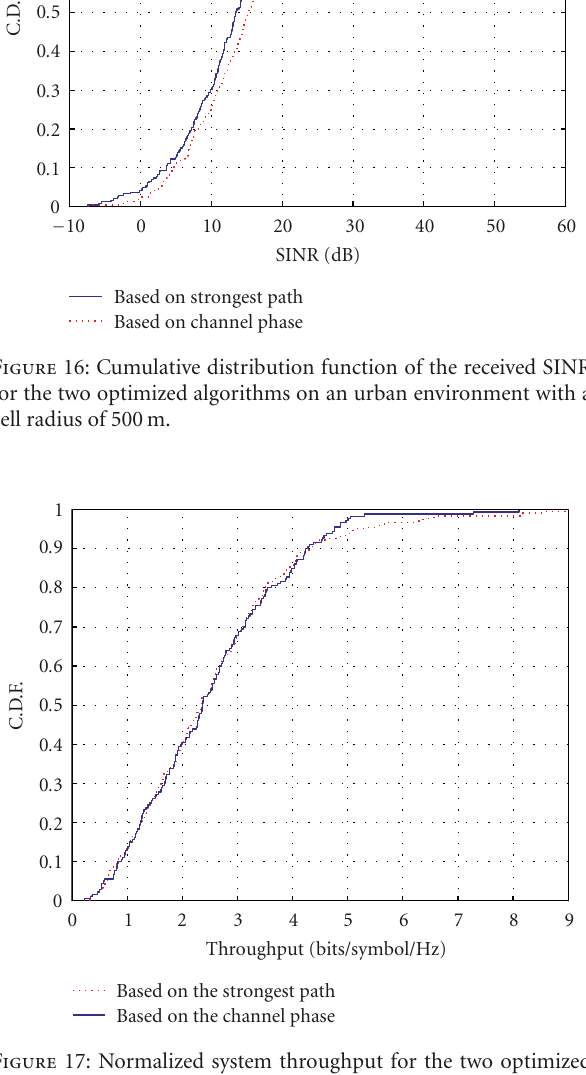
Figure 15: Normalized system throughput on a rural environment with a cell radius of 1000 m.